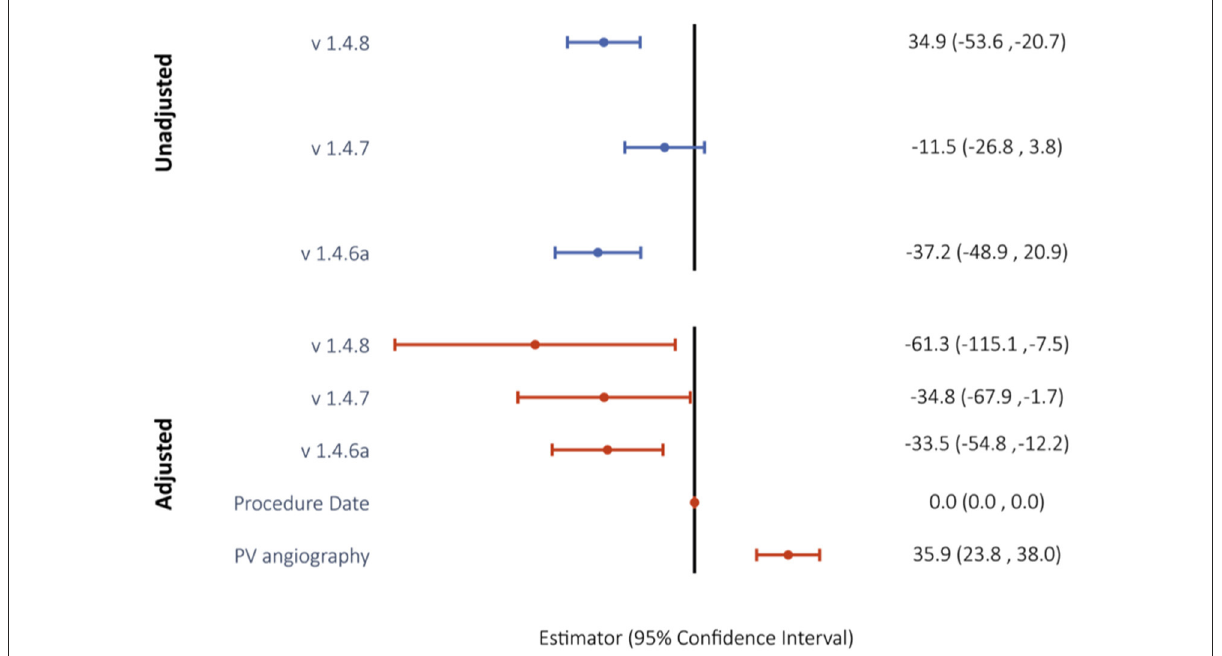
FIGURE4 Unadjusted and confounder-adjusted Tobit regression model to evaluate the impact of software version on use of contrast dye. Reported are Tobit estimates with 95% confidence intervals in brackets. Version 1.4.6 was used as the model